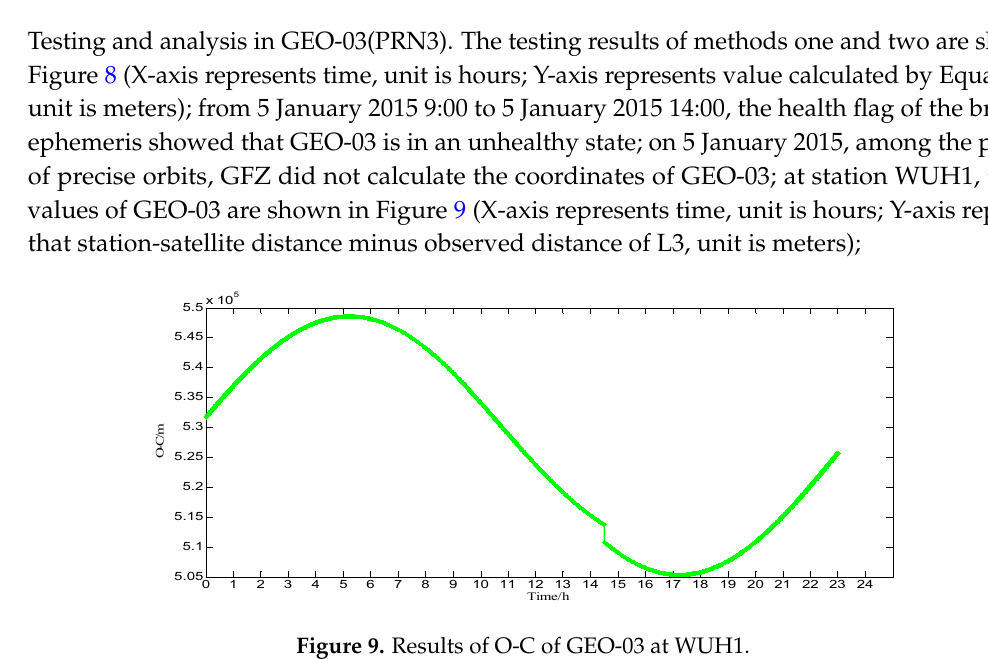
Figure 9. Results of O-C of GEO-03 at WUH1. Table 1. Results of GEO-03 maneuvering detection at 14:00–15:00. Table 1. Results of GEO-03 maneuvering detection at